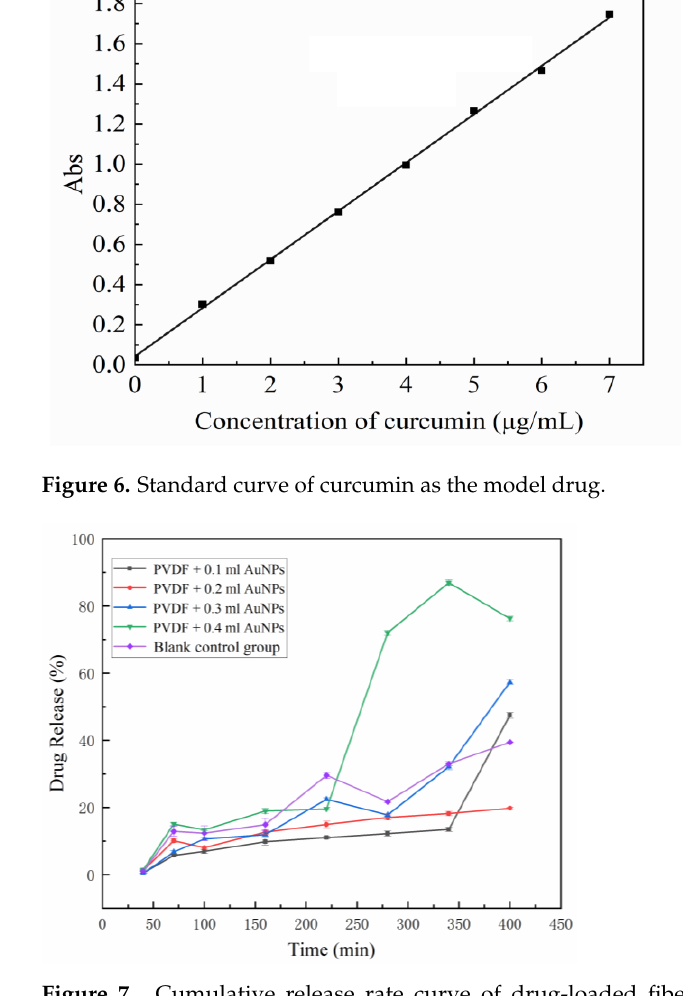
Figure 6. Standard curve of curcumin as the model drug.